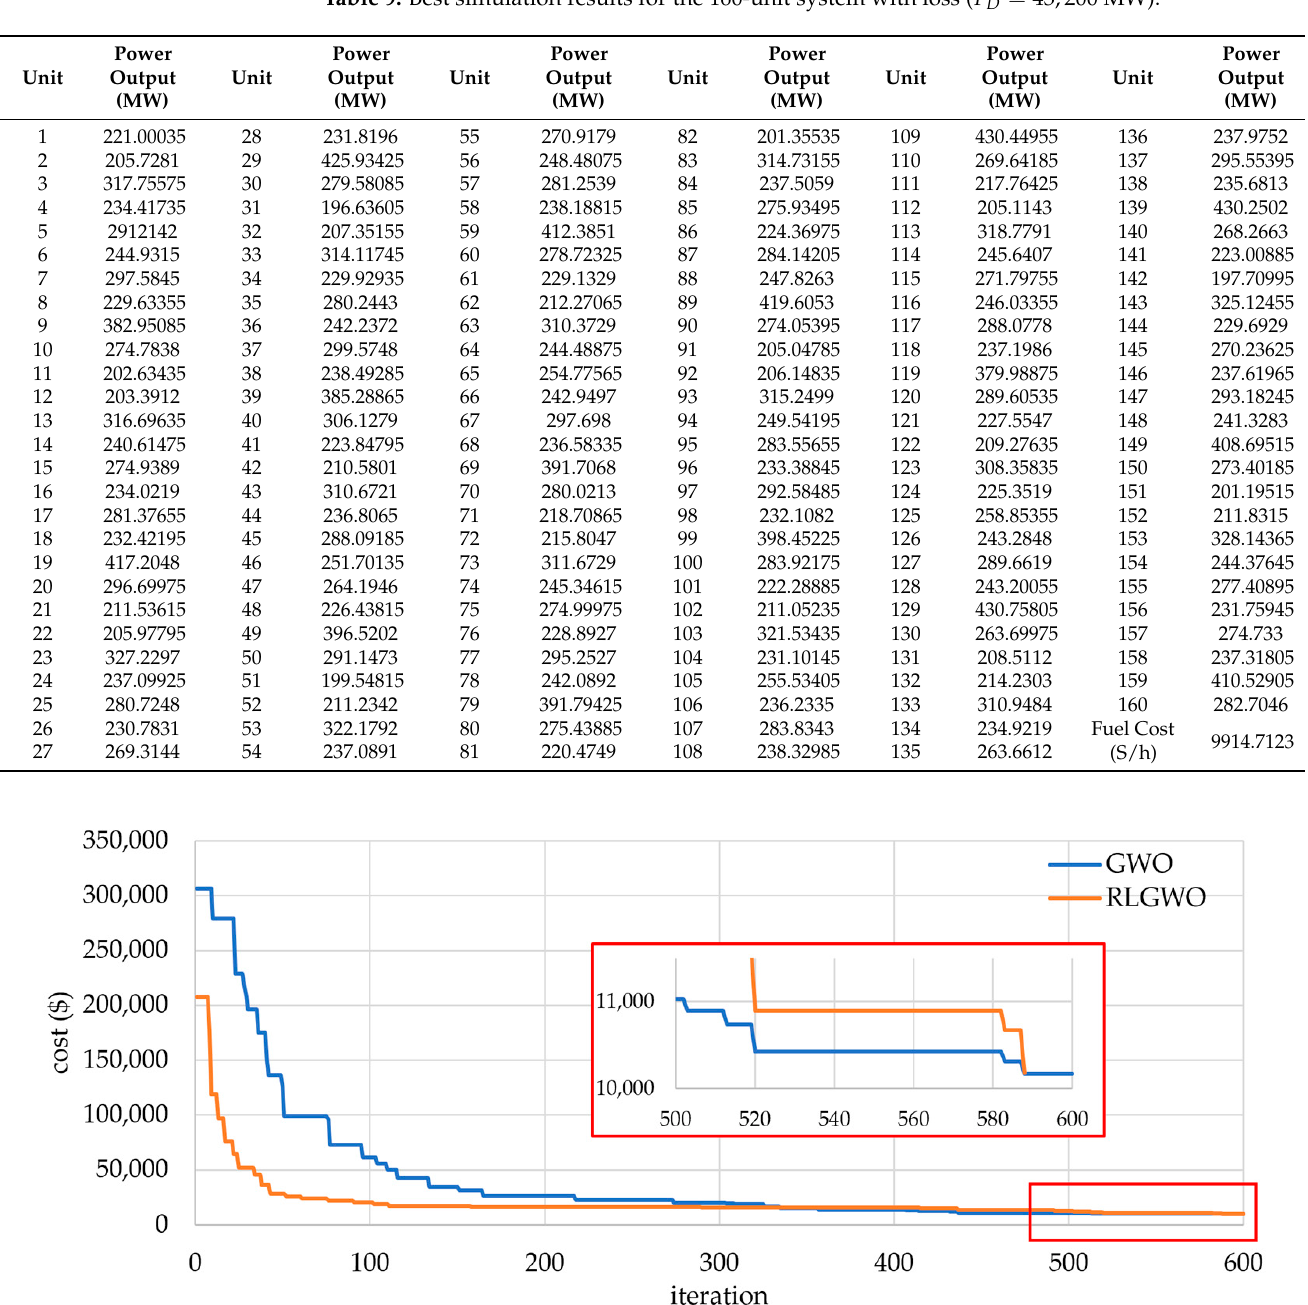
Table 10. Comparison between different methods taken after 50 trials (160 ‐ unit system).